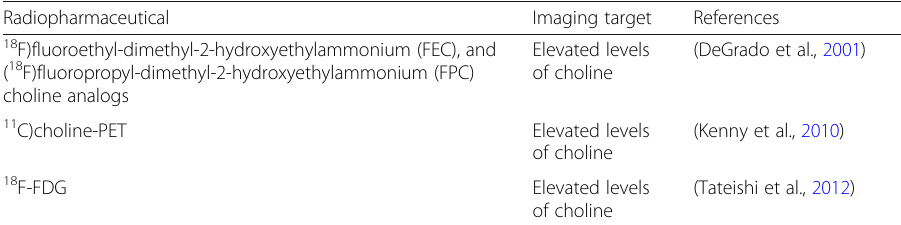
Table 1 Targeted pet/ct imaging and radiopharmaceuticals (Continued)